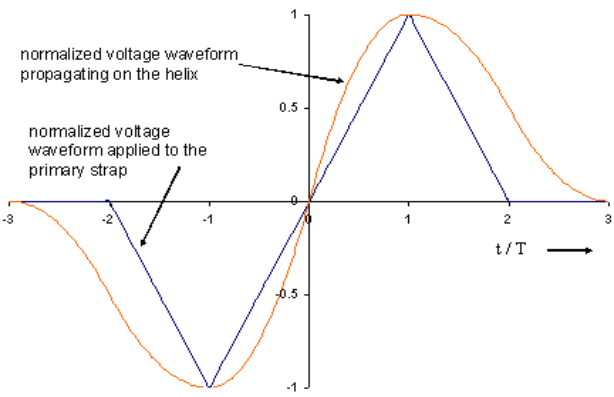
FIG. 9. (Color) Simple example of waveform smoothing when the primary flux coupling length is (cid:1) 1 form ramp length. The primary voltage waveform V in blue, where the peak amplitude of the voltage is normalized to unity and the time ( t ) is normalized by T (cid:3) l The resulting voltage waveform V (cid:4) (cid:3) (cid:6) propagating down the helix (cid:1) , where s vs the delayed time (cid:3) (cid:3) t (cid:5) z=v p 0 red, normalized by its peak amplitude (cid:3) ns